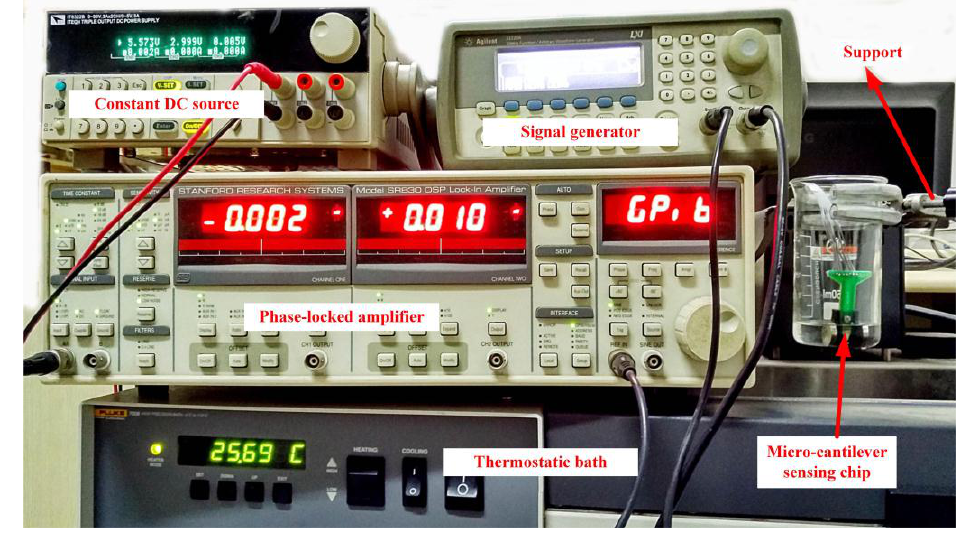
Figure 6. The experimental system.